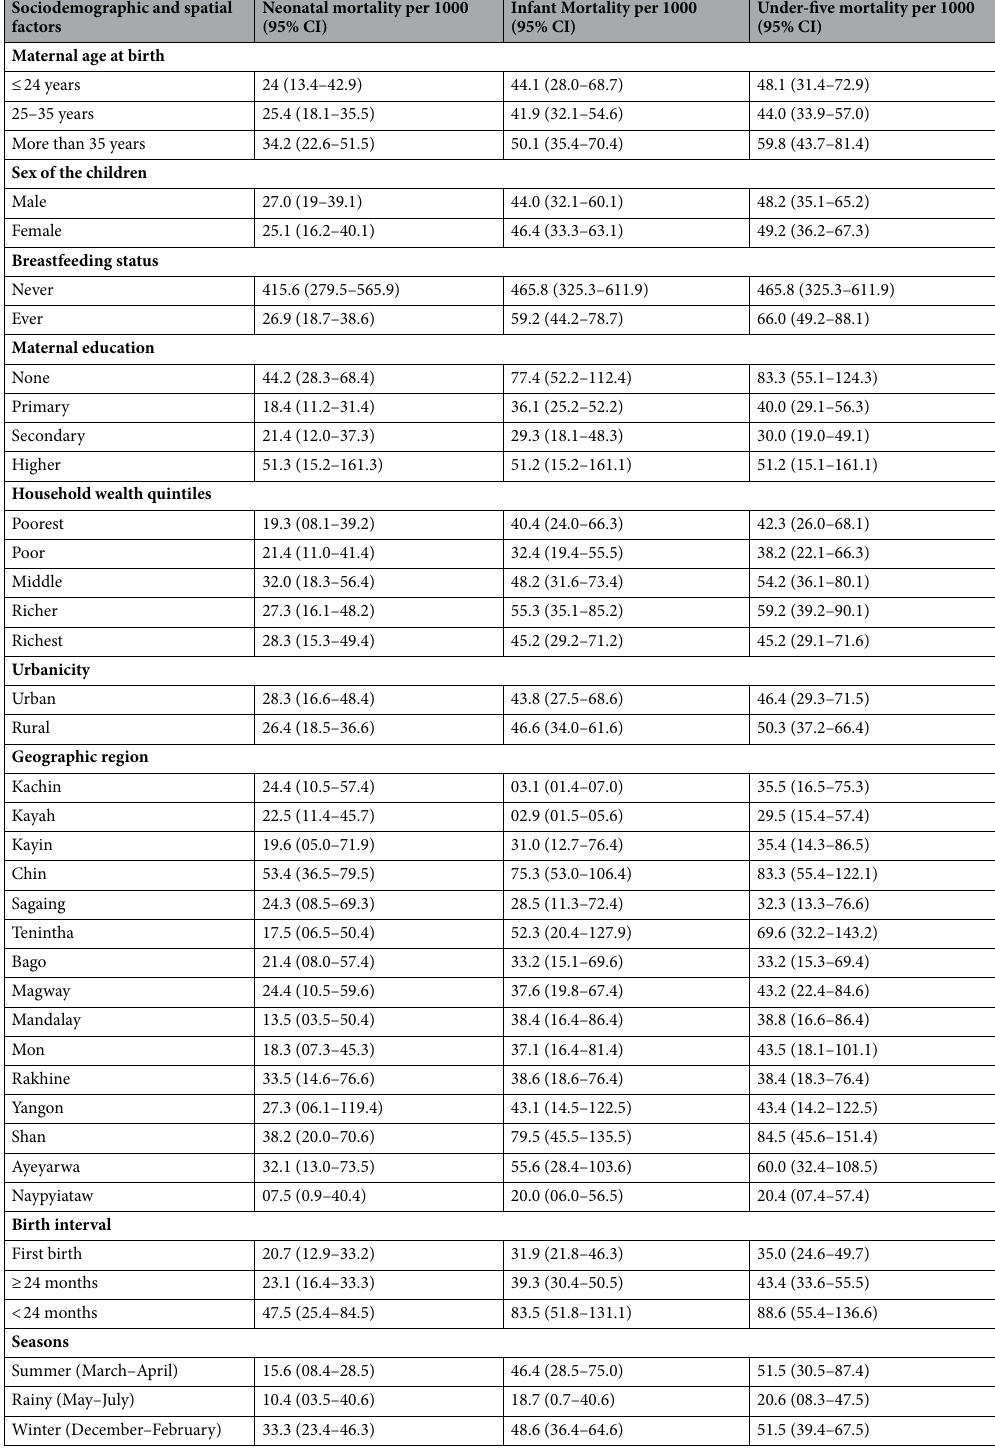
Table 2. Neonatal, infant, and under-five child mortality rates by sociodemographic and spatial factors